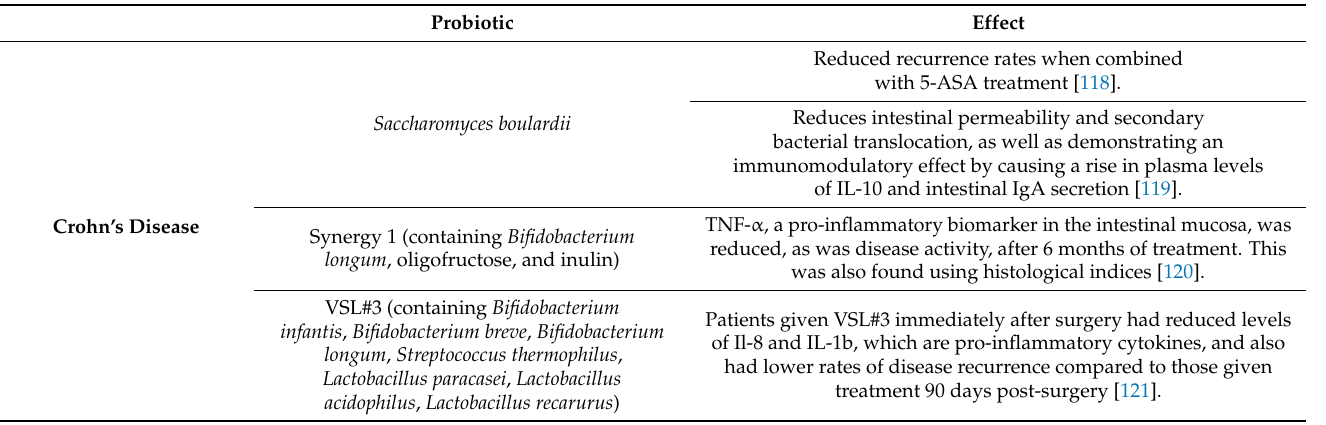
Table 6. Probiotics used in